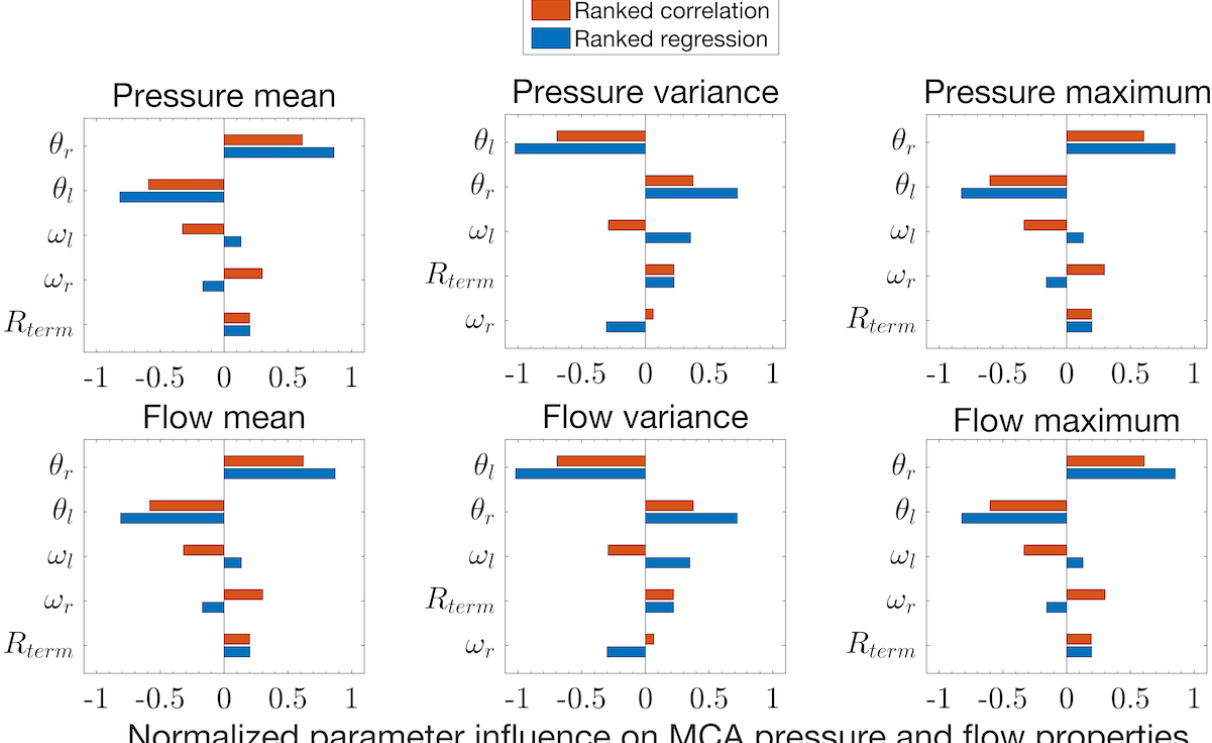
Figure 3. Ranked sensitivities of arterial network scaling parameters. Normalized empirical estimates of sensitivity ranking, shown here for key signal features (mean, variance, and maximum) of pressure (top row) and flow (bottom row) in the middle cerebral artery, summarize Monte Carlo experiments using global structured random uniform variations of scaling parameters (vertical axis of each panel). Parameter variations in vessel length ( θ l ) and radius ( θ r ) are most influential, whereas resistance scale ( R term ) and Windkessel scales ( ω l , ω r ) had relatively little impact on the solutions. The vessel dimension parameters have considerable influence on intracranial model inflow signals and provide global control while reducing the number of parameters needed to specify the hemodynamic model. MCA: middle cerebral